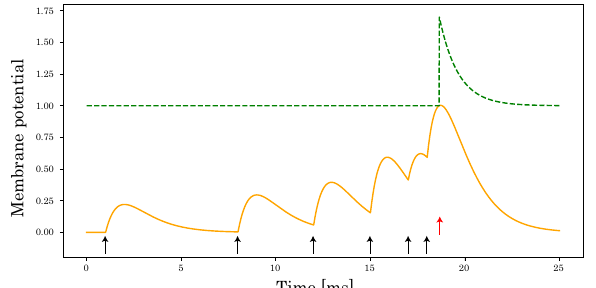
Figure 3. A dynamic threshold in SRM. The membrane potential (orange solid line) of the postsynaptic neuron is described by the superposition of the PSPs. Each input spike arrival and output spike are denoted by a black arrow and red arrow, respectively. At the moment of spiking, the firing threshold (green dashed line) increases and decreases with time to the initial value of the firing